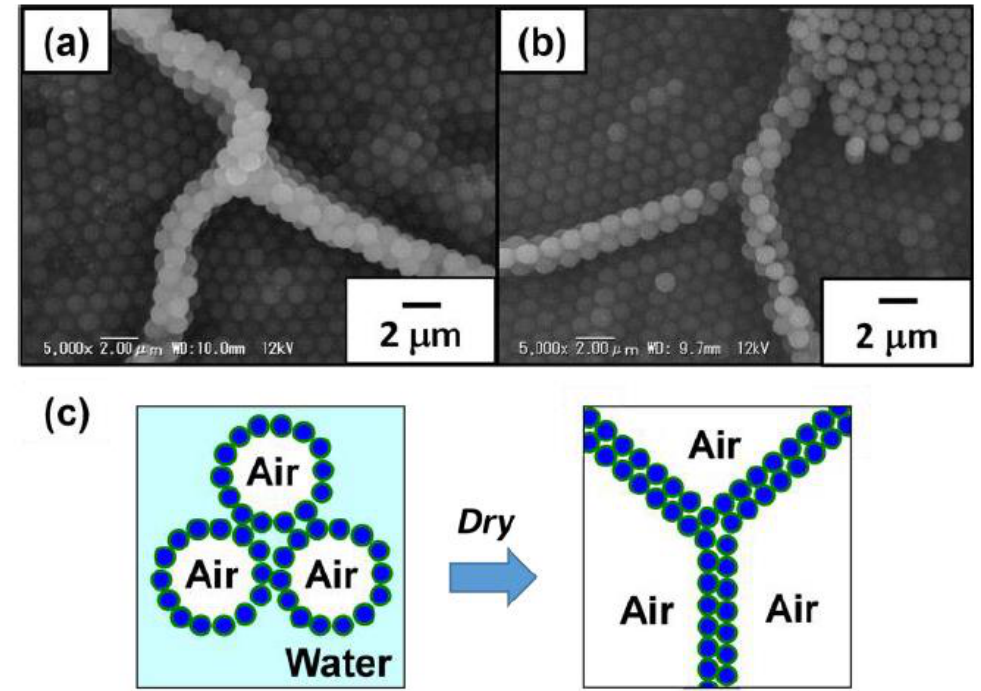
Figure 4. Cross-sectional SEM images of dried foams stabilized with ACMPA-PS particles prepared at ( a ) pH 2.0 and ( b ) pH 4.8 after rupturing using a razor blade. ( c ) Scheme illustrating formation of bilayers of ACMPA-PS particles array via drying.